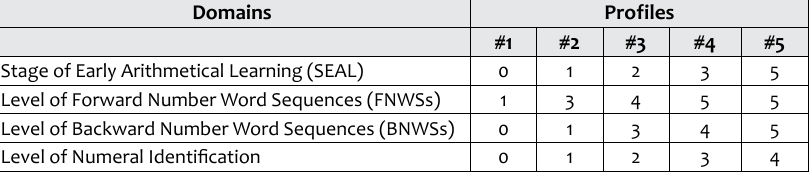
Table 3: Examples of children’s profiles on LFIN.